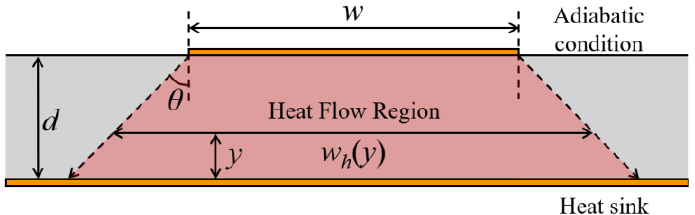
Figure 4. Cross-sectional view of the heat flow region in the constant-angle model.